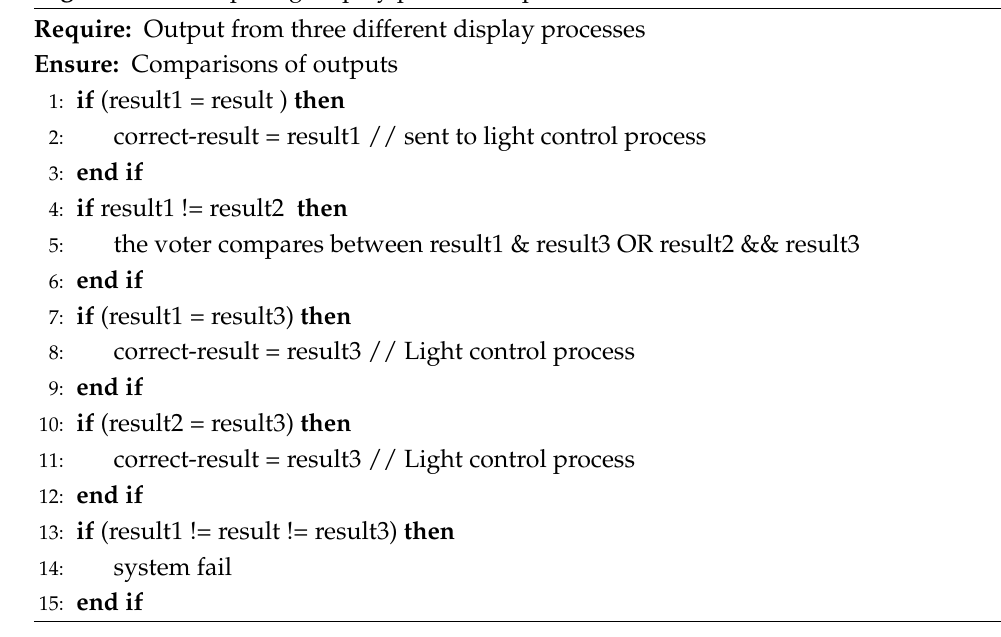
Algorithm 2 Comparing display process output.